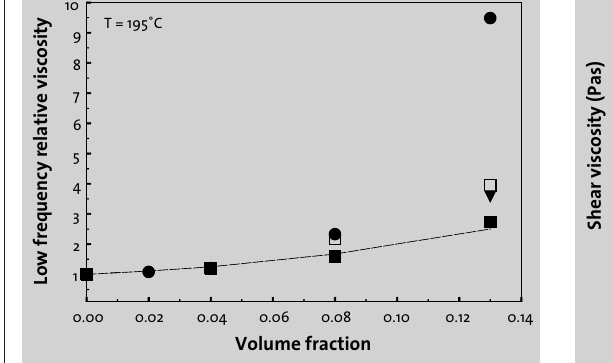
Figure 7 (left): Variation of low frequency relative vis- cosity versus talc volume fraction (experimental data: Ê talc1/LLDPE, ‡ talc3/LLDPE, Ù talc1/LDPE, · talc1/PA12; model prediction: — one-parameter equation ( F m = 0.35) Figure 8 (right): Variation of the talc1/LLDPE shear viscos- ity versus shear stress at different volume fractions (X 0%, + 4%, Ú 8%, Ê 13%, Ï